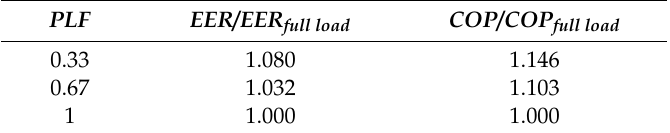
Table 3. Manufacturer data for Clivet model WSHN-XEE2. E ff ect of PLF on the HP performance. PLF EER / EER full load